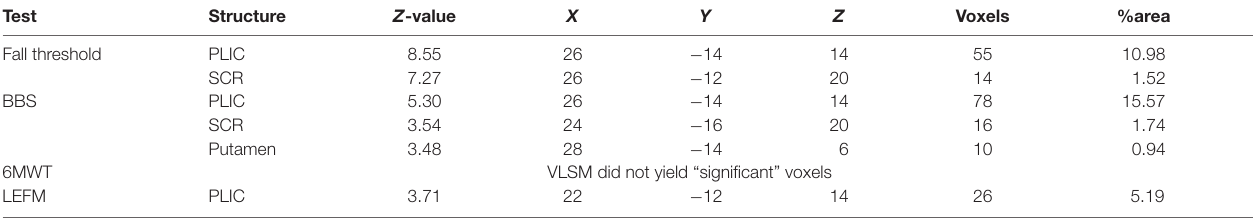
TABLE 3 | Voxel-based lesion symptom mapping (VLSM) results in right hemisphere damaged (RHD) patients, n = 24. Test